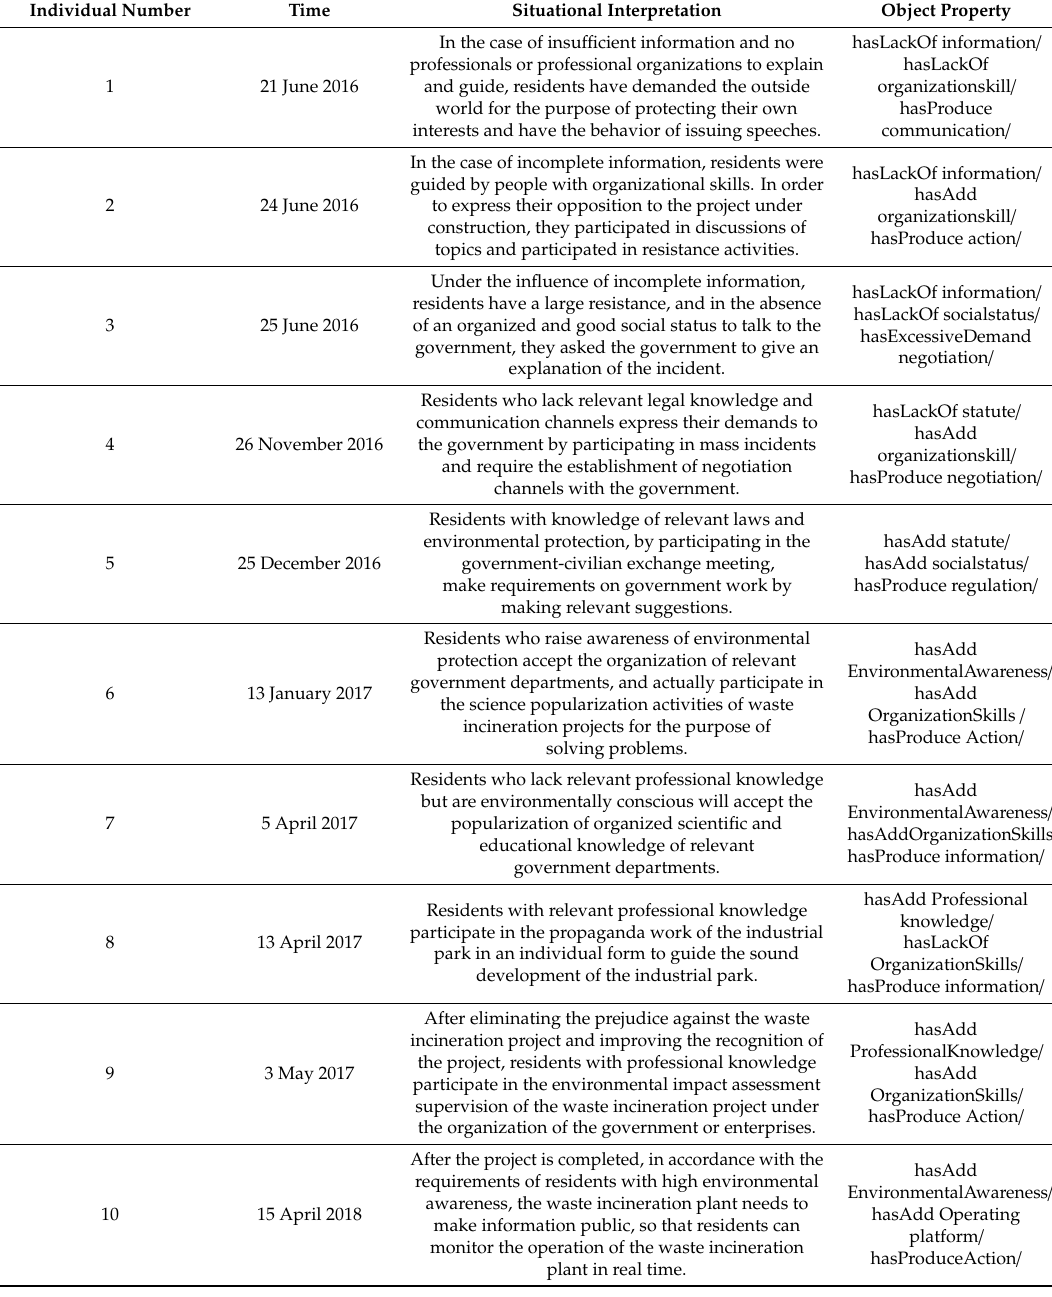
Table A2. The individual